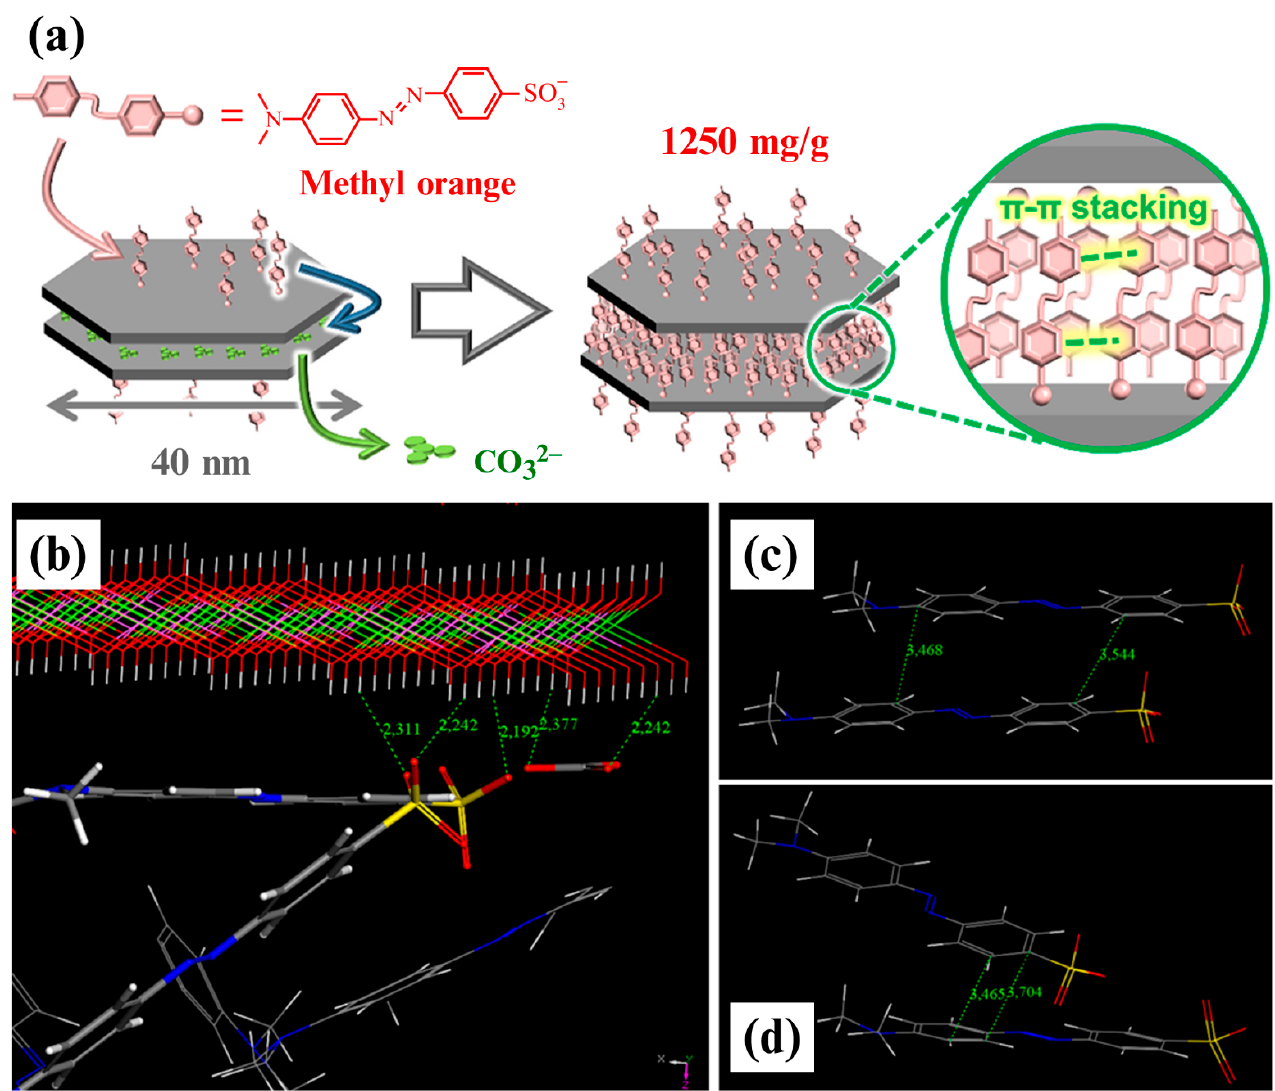
Figure 2. ( a ) Mechanism of the substitution of CO 32 − anions by methyl orange (MO); ( b ) snapshot of the interactions between the MO/CO 32 − and layered double hydroxide (LDH) layers and ( c , d ) π – π stacking of MO in an LDH simulated by the Monte Carlo method. Reproduced with permission from [17].